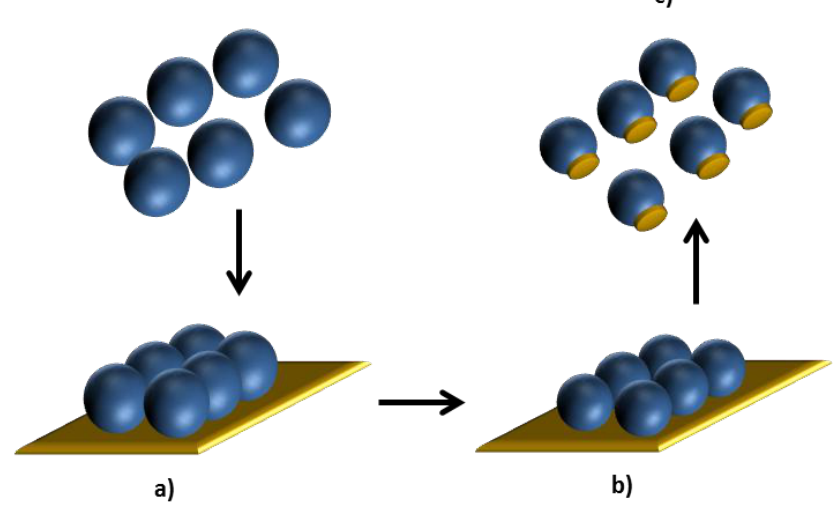
Figure 11. Hybrid polystyrene/gold nanoparticles prepared by: ( a ) adhesion of the particles on Au layer; ( b ) size reduction by plasma etching; ( c ) release from substrate. Self-drawn scheme based on the strategy reported in